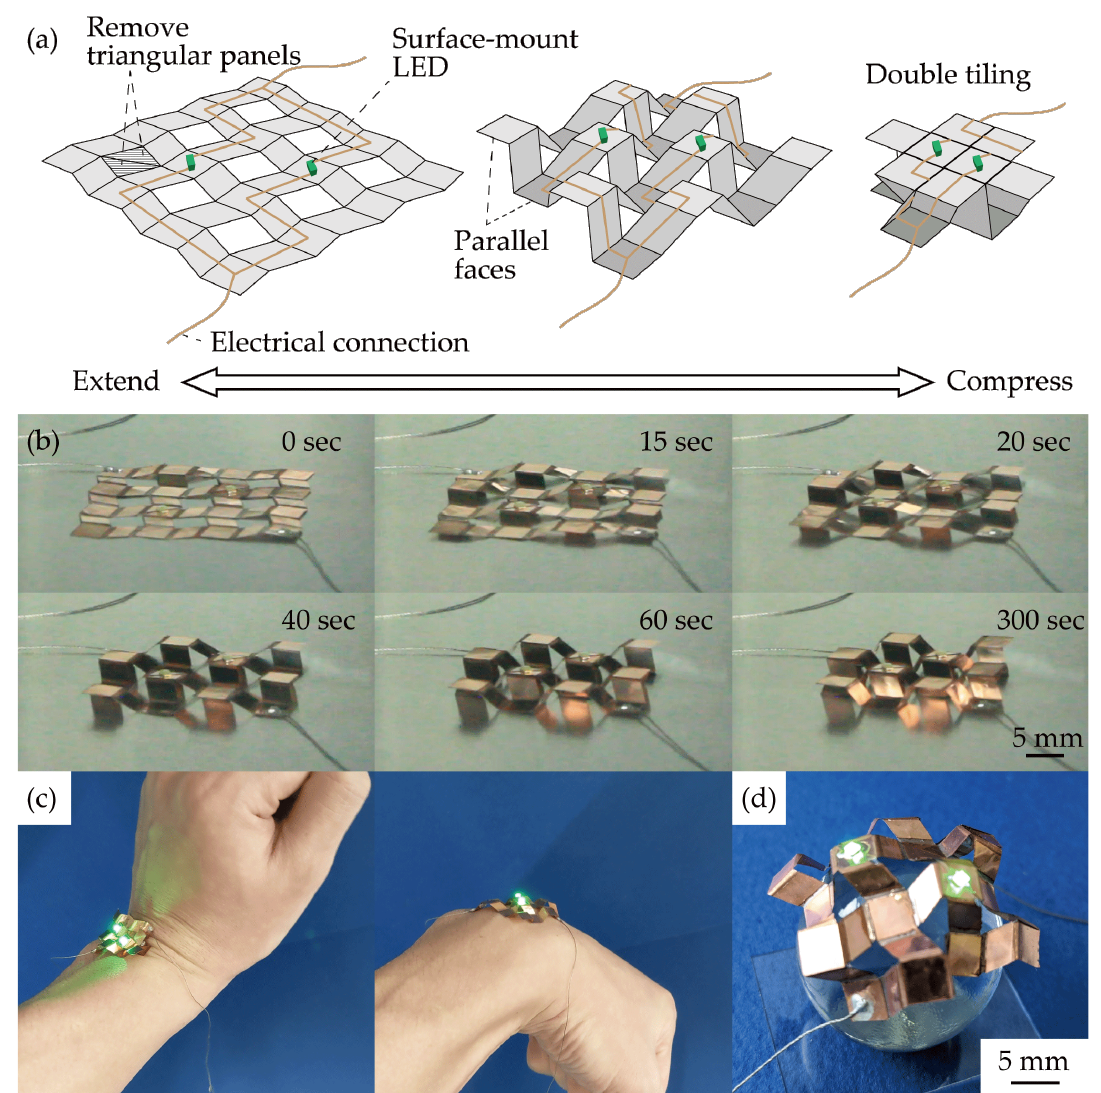
Figure 5. Demonstration. ( a ) Schematic diagram of the device. ( b ) Device during self-folding. ( c ) Attached to a curved human wrist. ( d ) Attached to a 30 mm diameter sphere.